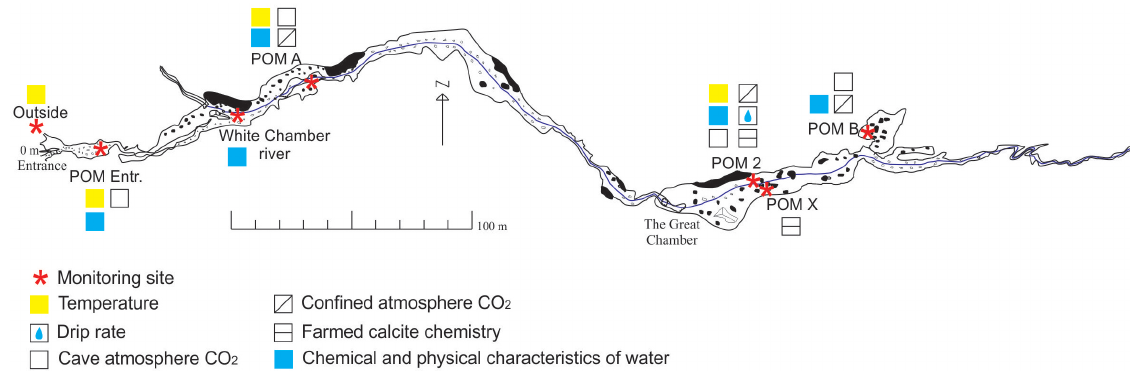
Figure 2. Map of Ascuns ˘ a Cave with the locations of the monitoring sites